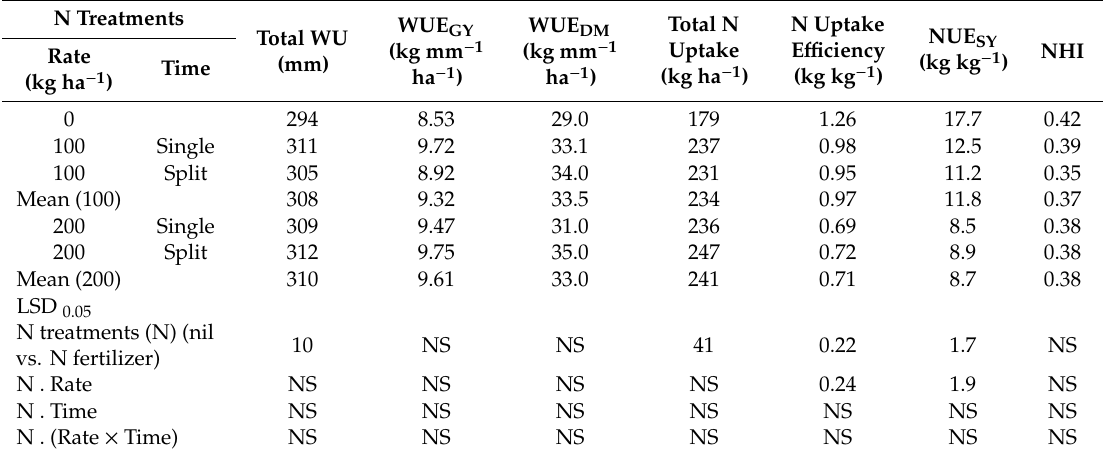
Table 7. E ff ect of di ff erent N applications on water use, water-use e ffi ciency, N uptake e ffi ciency, N-use e ffi ciency for seed yield and nitrogen harvest index (NHI) of rainfed canola at Tarlee site *. N Treatments